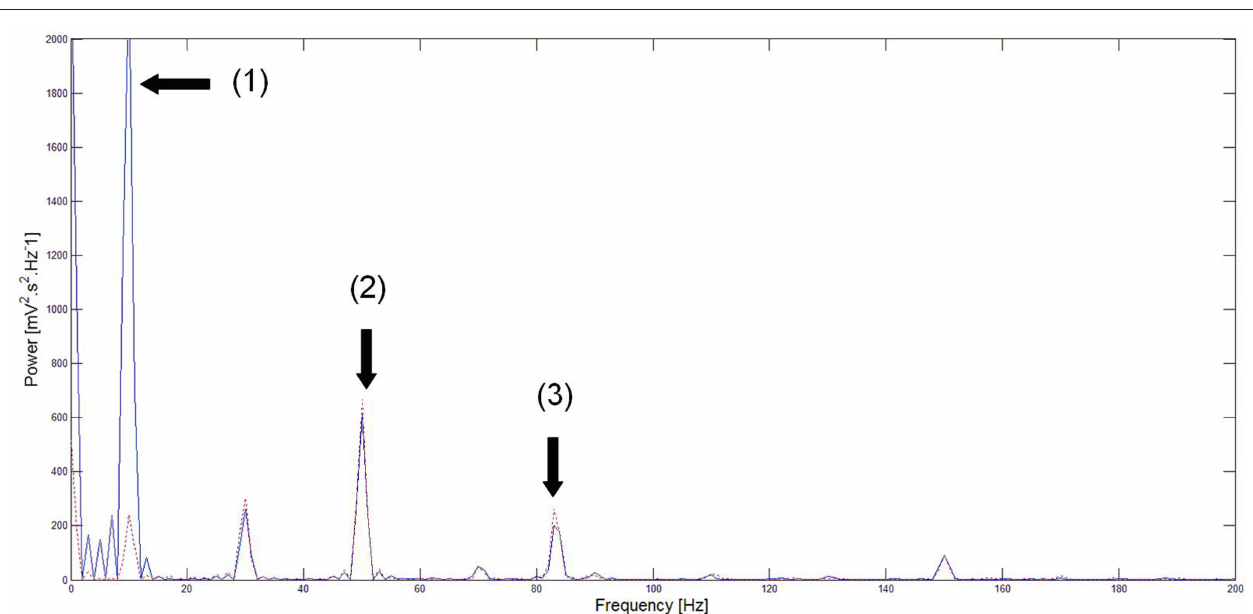
other frequency bands appear minimally affected. Note: (1) = strong attenuation of the 10 Hz peak, (2) and (3) = slight perturbation of the 50 and 85 Hz peaks respectively. This means that the closed-loop stimulation signal minimally interferes with the processing of inputs to the network at non-“pathological”